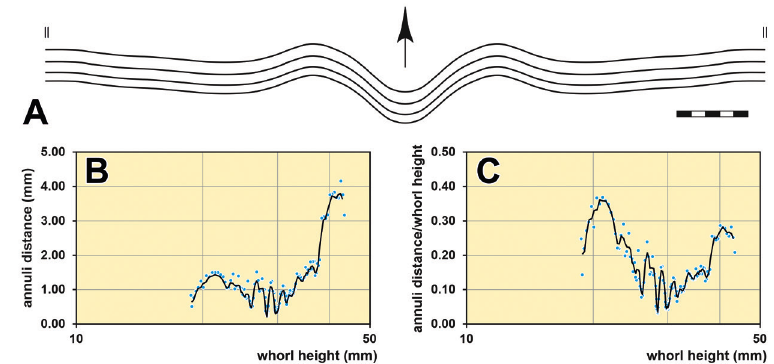
Fig. 68. Trilacinoceras knoefleri sp. nov. from the Upper Grey Orthoceratite Limestone. A . Lirae of paratype MB.C.30559 (Krueger Coll.) from Mukran (Sassnitz, Island of Rügen) (Mecklenburg- Vorpommern), at wh = 14 mm. B–C . Ontogenetic development of annuli distance (in mm) and annuli distance/whorl height of holotype MB.C.11658 (Knöfler Coll.) from Teschendorf near Löwenberg (Brandenburg). Blue dots = individual measurements, black lines = three data point averaged values. Scale bar units = 1